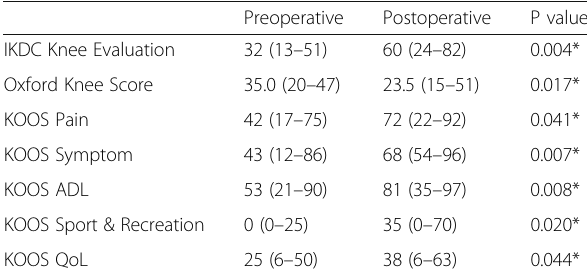
Table 3 Differences in knee function, pain and knee-related quality of life as measured with PROMs Preoperative